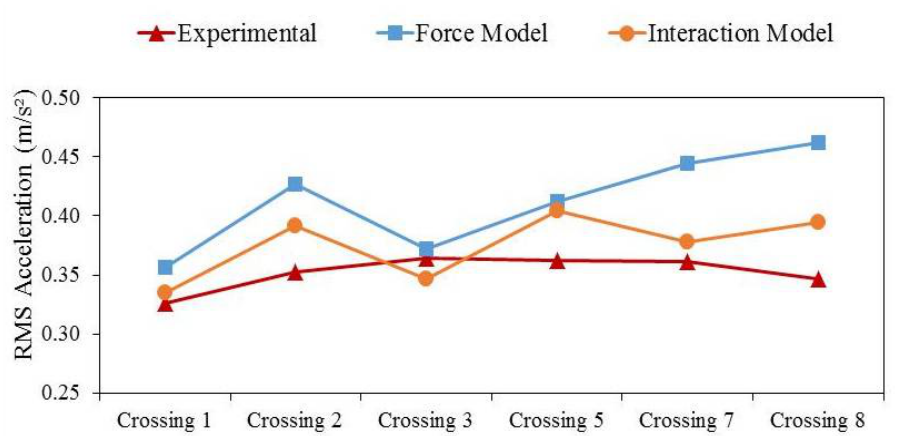
Figure 10. Root mean square (RMS) results from the crossings of the group.